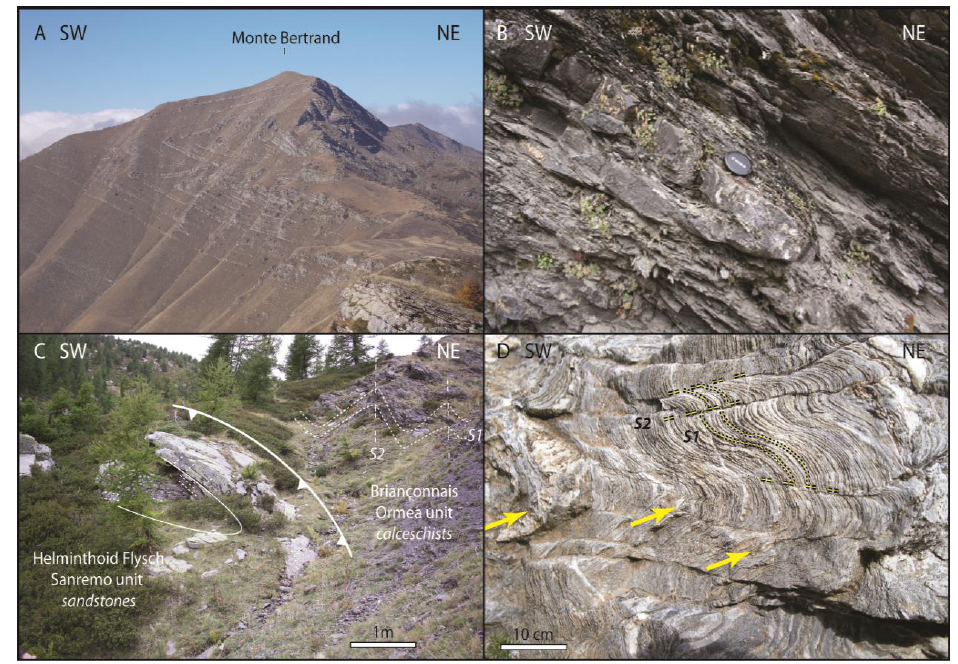
Figure 5. Deformation features from cross-section A-A’. Sub-isoclinal folding of the carbonate turbidites ( A ) and pelite basal complex ( B ) in the Sanremo unit. Rocks from the Sanremo unit show a single foliation ( B , C ), whereas the Briançonnais calcschists show two overlapping foliations with different orientations ( C , D ).